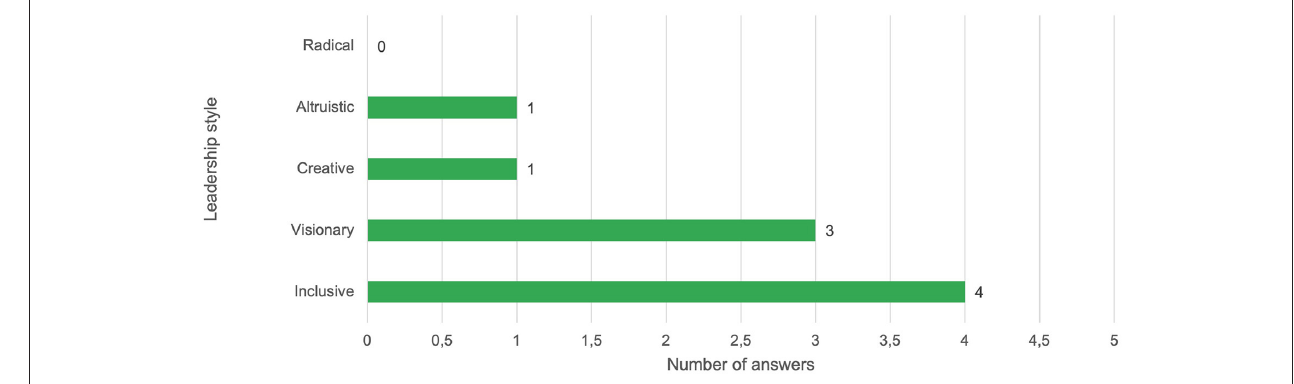
FIGURE 3 | Sustainability leadership style.